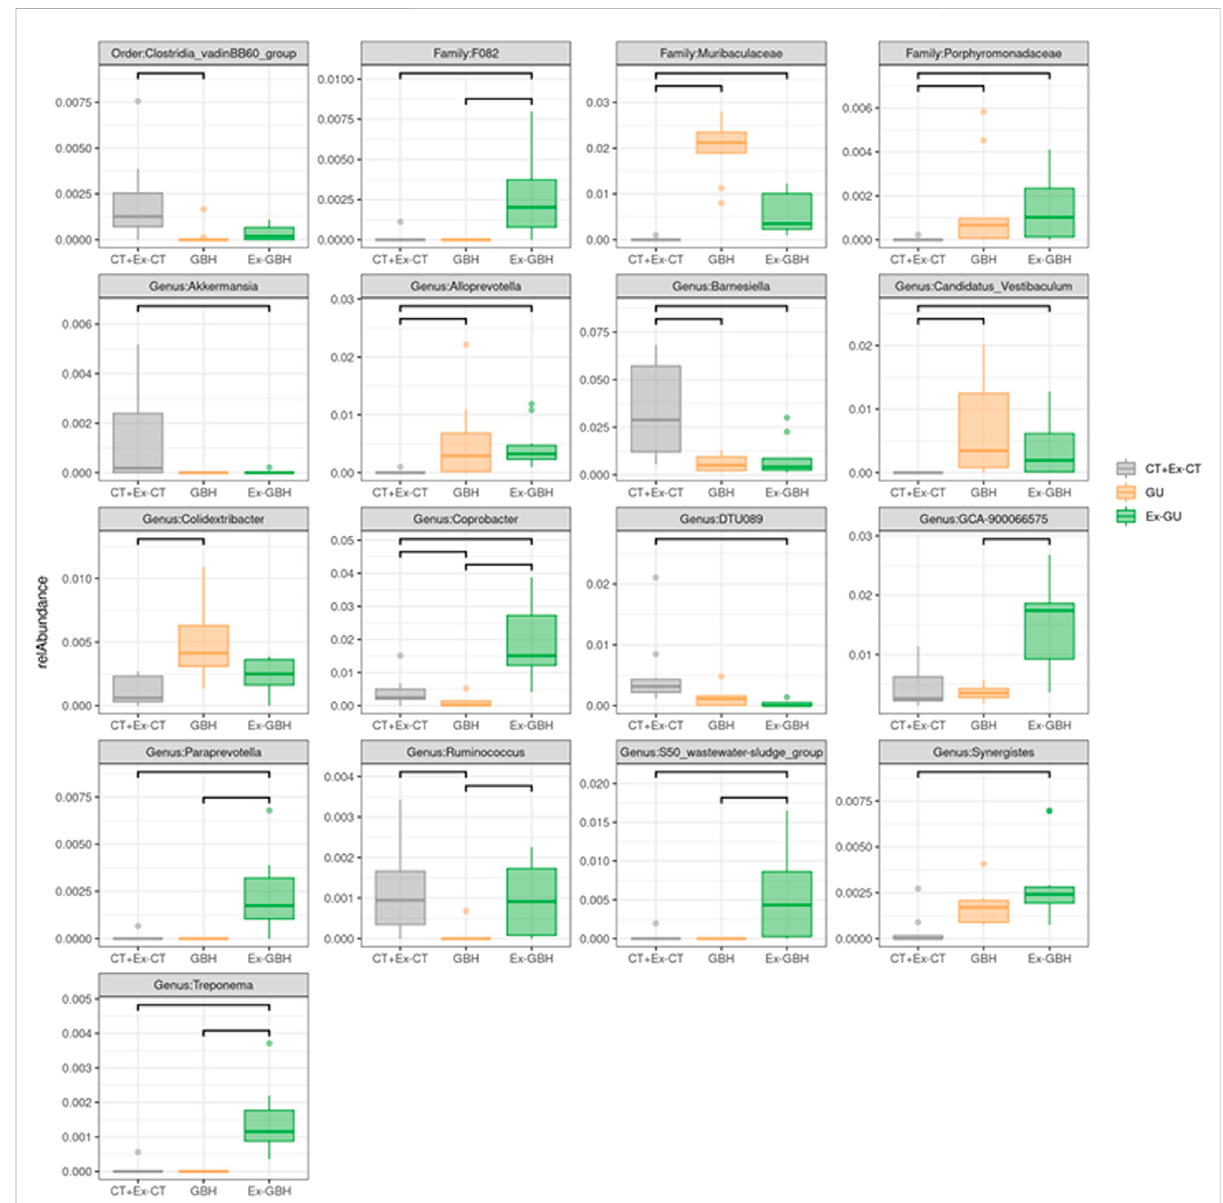
FIGURE 7 Relative abundance of differential taxa in cecal content of hens exposed to GBH for 42 days (GBH, n = 9), exposed for 42 days then non- exposed until D70 (Ex-GBH, n = 12) and controls at D42 and D70 taken together (CT + Ex-CT, n = 10), commonly identi fi ed by ALDEx2, DESeq2 and ANCOM-BCmethods.Abarbetweentwogroupsindicatesthattherelativeabundanceissigni fi cantbetweenthesetwogroups.Taxaareidenti fi edat order, family and genus levels Results are presented as means ± SEM. *p ≤ 0.05. CT + Ex-CT: Control and ex-Control taken together, GBH: Glyphosate-Based Herbicide,